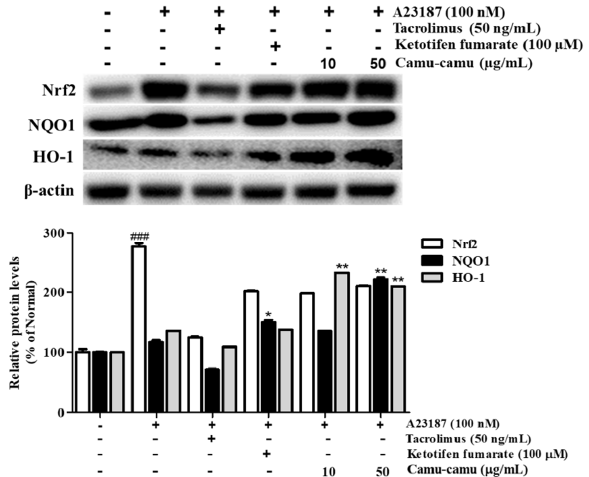
Figure 9. Effect of camu-camu fruit extract on Nrf2 activation in A23187-induced RBL-2H3 cells. Band intensities were quantified by densitometry, normalized to the level of β -actin. Then, it was calculated as a percentage of non-treated cells and displayed as mean ± SD of three independent experiments ( ### p < 0.001 vs. the control group, * p < 0.05 and ** p < 0.001 vs. the A23187-treated group).